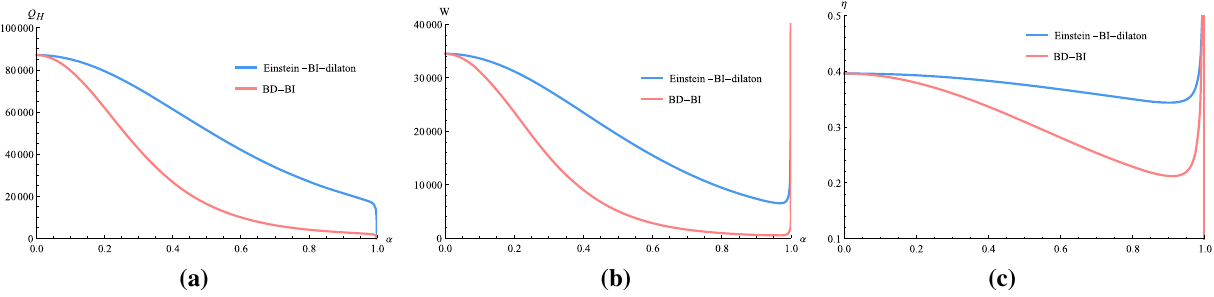
Fig. 11 Plots for ( a ) the net inflow of heat ( b ) total work done and ( c ) the efficiency vs. α (see the caption of Fig. 2 for parameter